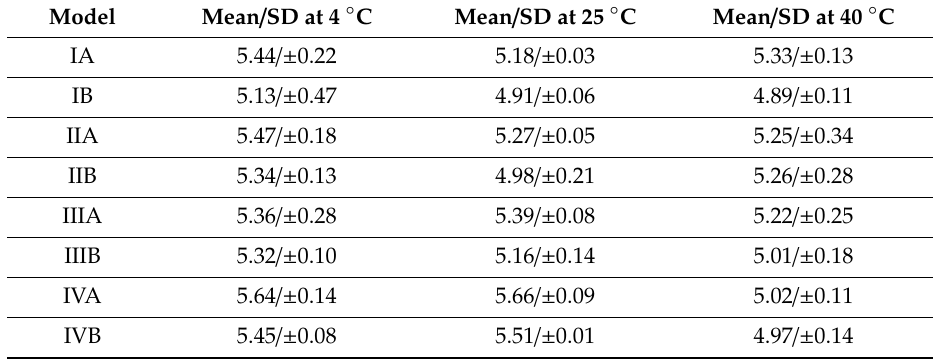
Table 2. Average cumulative pH values / deviation after 28 days for each product stored at 4 ◦ C, 25 ◦ C and 40 ◦